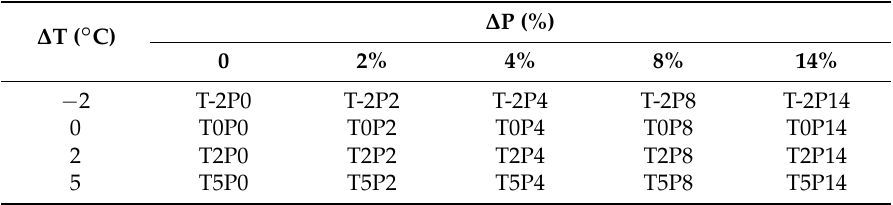
Table 4. Climate scenarios of different changes of temperature and precipitation.